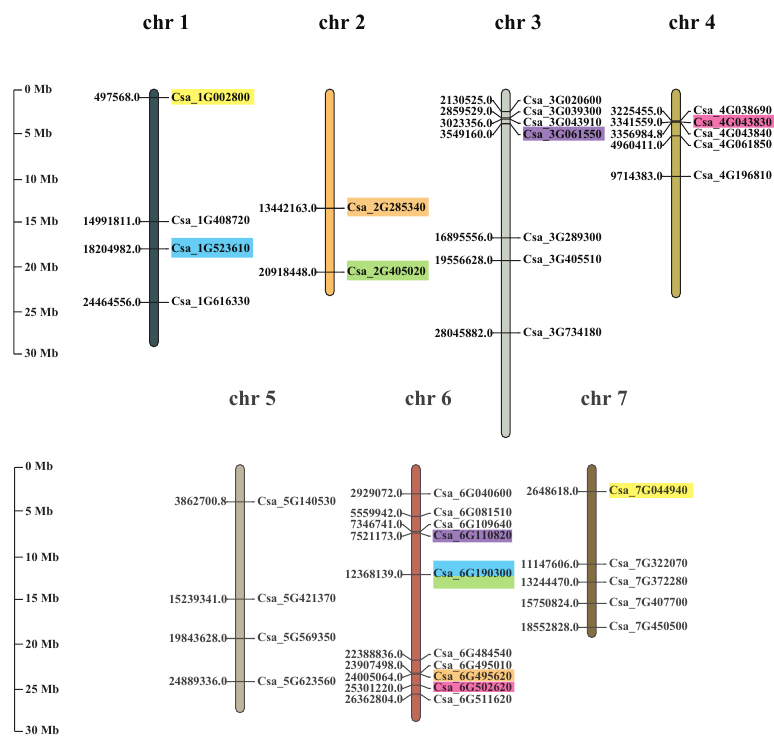
Figure 3. Chromosome mapping and duplication of CsaGRAS genes in cucumber. The number on the left side of the chromosome is the starting position, and on the right is the gene ID; segmental duplication gene pairs are marked with di ff erent color blocks and tandem duplication gene pairs are marked with green